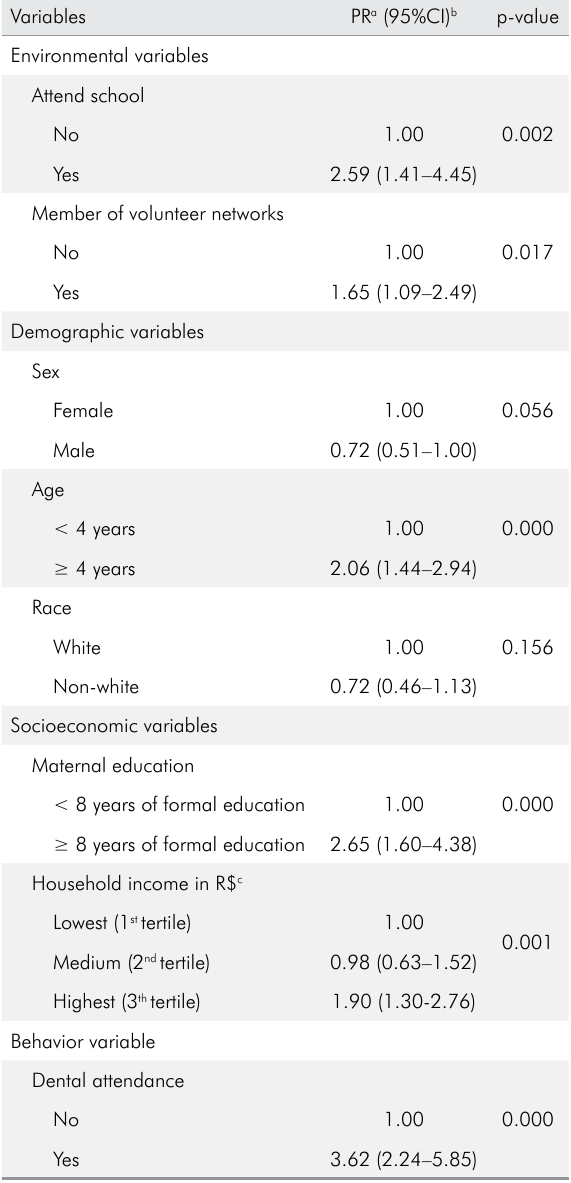
Table 2. Unadjusted association of variables with use of dental floss, determined using Poisson regression with robust